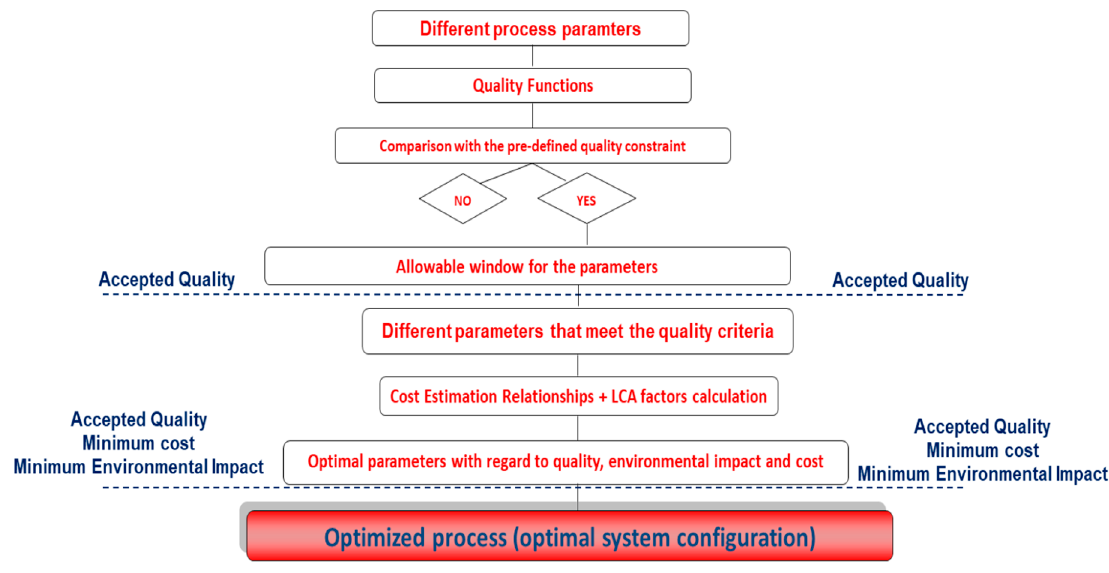
Figure 5. Flow chart of the optimization process.